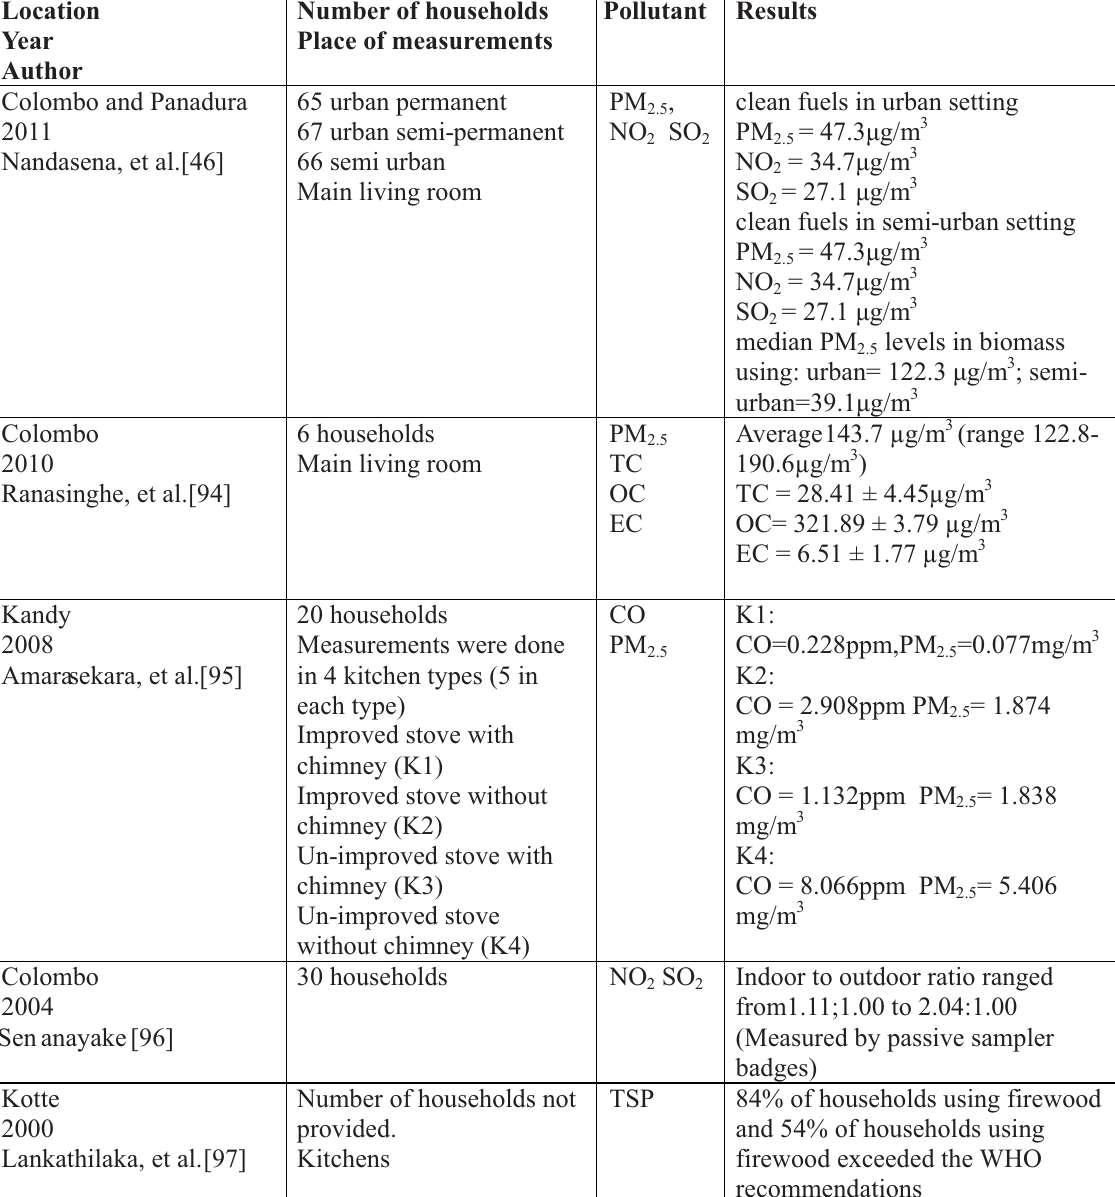
Table 1: Studies monitored indoor air pollution levels in Sri Lankan